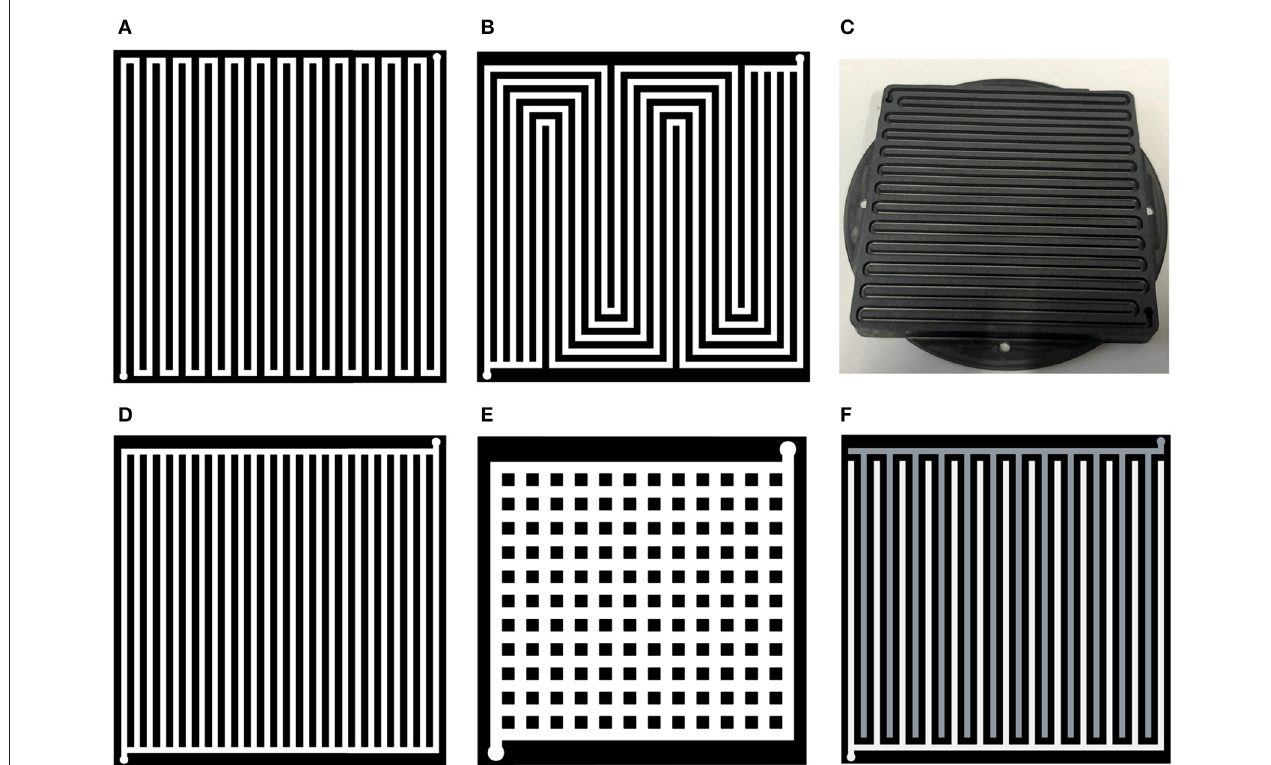
FIGURE 2 | Schematic pictures of conventional FFP designs: 1-channel serpentine (A) , 5-channel serpentine (B) , parallel (D) , pin-type (E) , interdigitated (F) , and a photo of the 1-channel serpentine with 50 × 50mm FFP (C) ; the inlet channels are marked in white the outlet ones are in